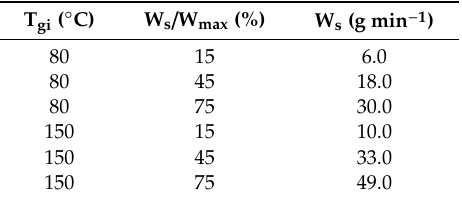
Table 1. Spouted bed drying parameters used in manufacture of the dried